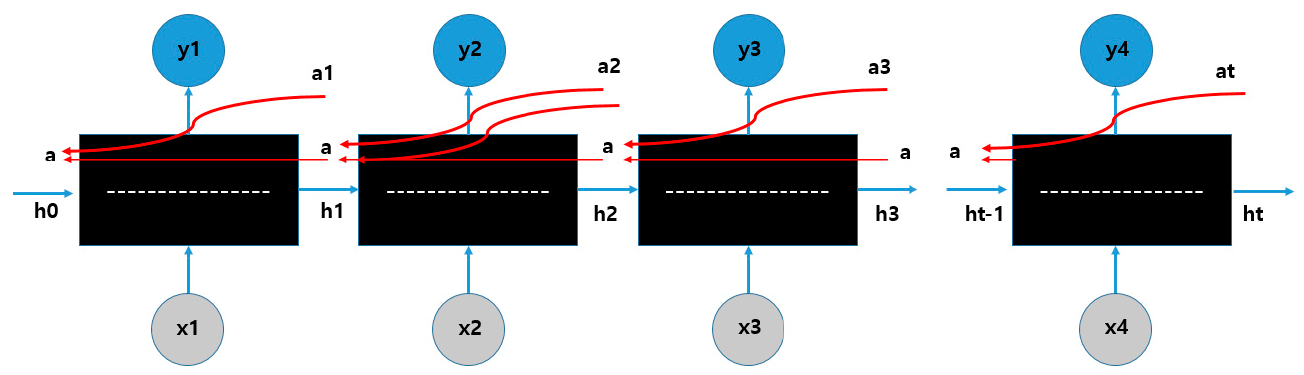
Figure 4. BPTT (Back Propagation Through Time).